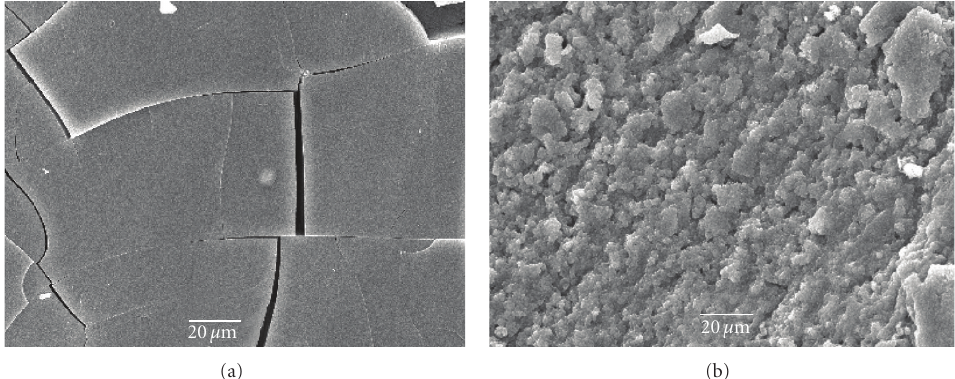
Figure 3: SEM images. Surface morphology of the dried samples of TiO 2 sols obtained by hydrolysis of TIP at 20 ◦ C (a) and 95 ◦ C (b).